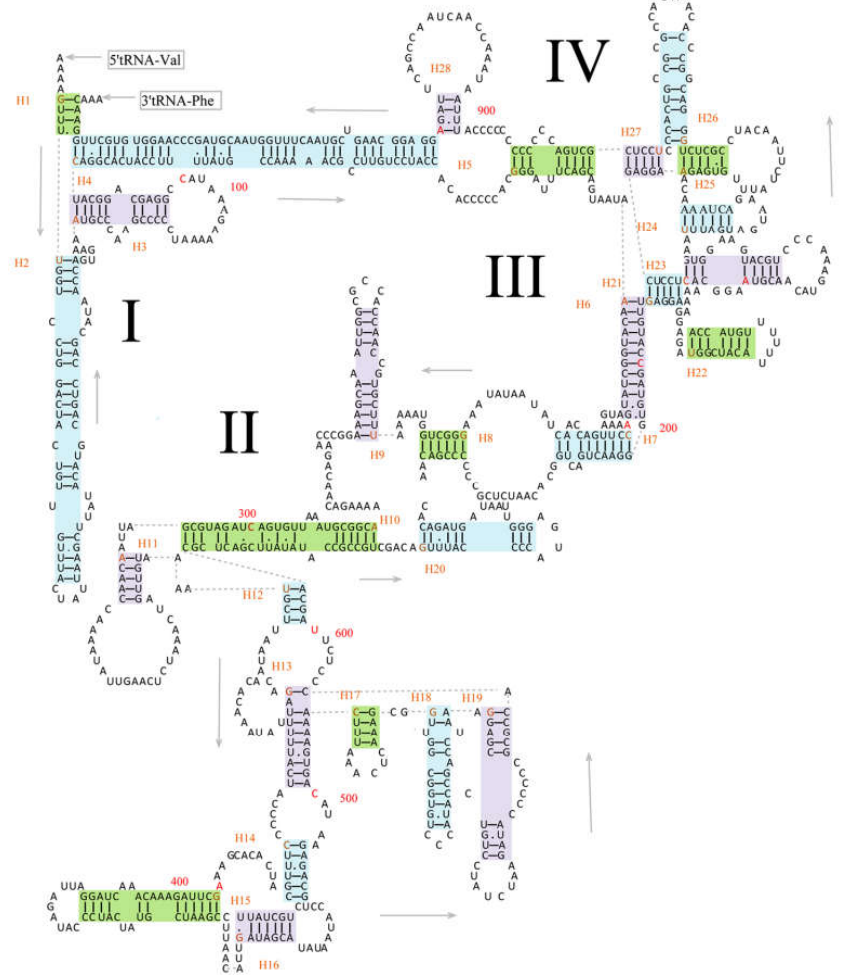
Figure 3. Predicted secondary structure of the 12S rRNA in E. scripta KZL15. Watson-Crick base pairings are indicated by the dashes (–); G–U base pairings are indicated by dots ( • ). Roman numerals indicate the conserved domain structures; I–IV indicate four domains in the secondary structure of 12S rRNA. Every 100th base is marked in red. Helices were marked with green, purple, and blue. The number of helices and the first base of helix were marked in orange; H means helix. Generated using RNAfold [43] and edited using Microsoft PowerPoint (14.0.4760.1000).